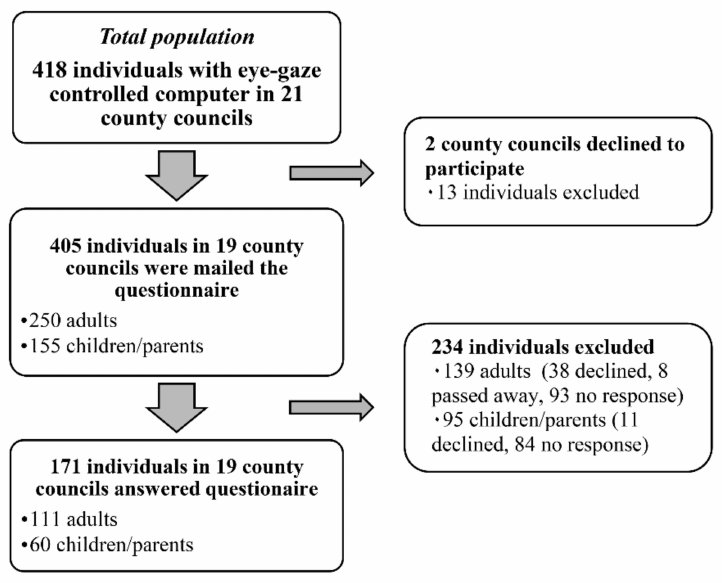
Figure 1. Flow chart of study